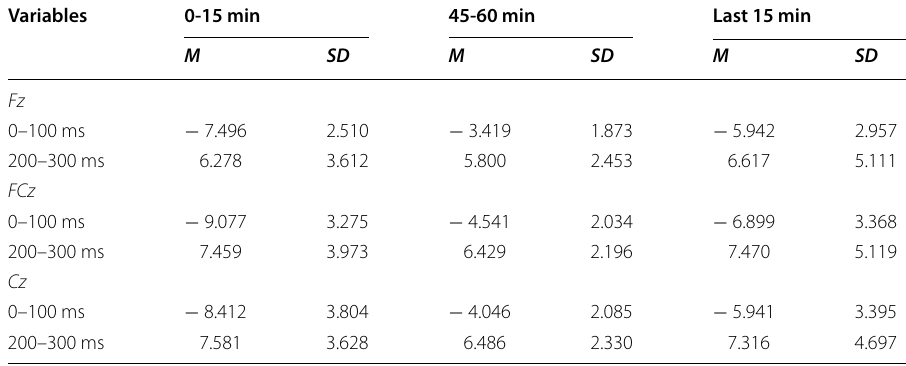
Table 2 ERN and early Pe for three electrode positions at different time periods Variables 0-15 min 45-60 min Last 15 min M SD M SD M